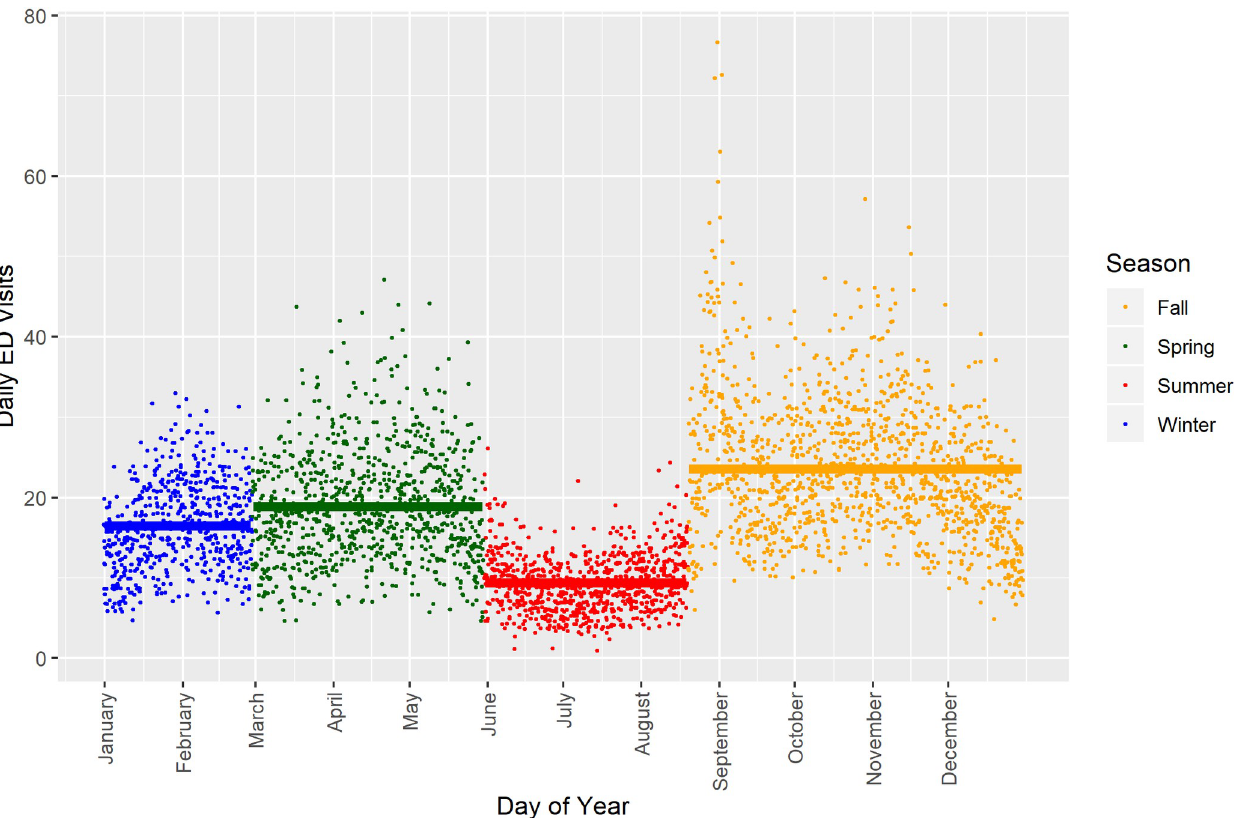
Fig 2. Asthma emergency department (ED) visits for ages 5–19 years from 2005 to 2014 in South Carolina grouped by admittance day of the year and asthma season (winter: January 1 –February 28/29; spring: March 1 –May 31; summer: June 1 –August 19; fall: August 20 –December 31). Seasonal mean daily ED visits were 16.5 visits/day/year in winter (medium burden), 18.9 visits/day/year in spring (medium-high burden), 9.4 visits/day/year in summer (low burden), and 23.5 visits/day/year in fall (high